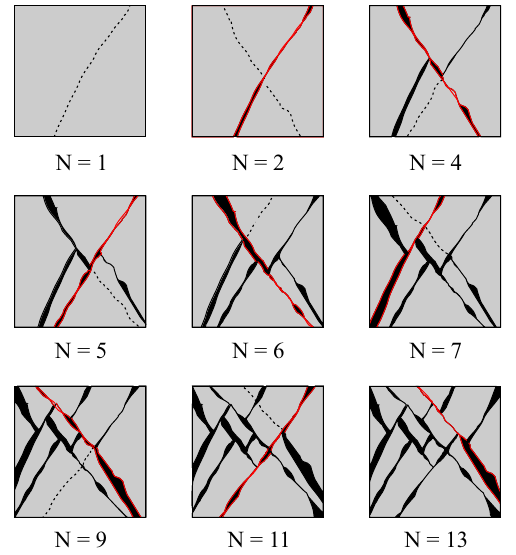
Figure 17. Simplified mechanical model illustrating a rapidly in- creasing number of (smaller) microlithons by conjugate shearing. For better visibility, the model exaggerates the shear offset, which might lie in the range of only a few µm for scaly clay shear zones. Shear zone asperities create releasing and restraining bends, the first filled with calcite veins, the latter leading to geometrical “locking- up”, causing the development of new (smaller)